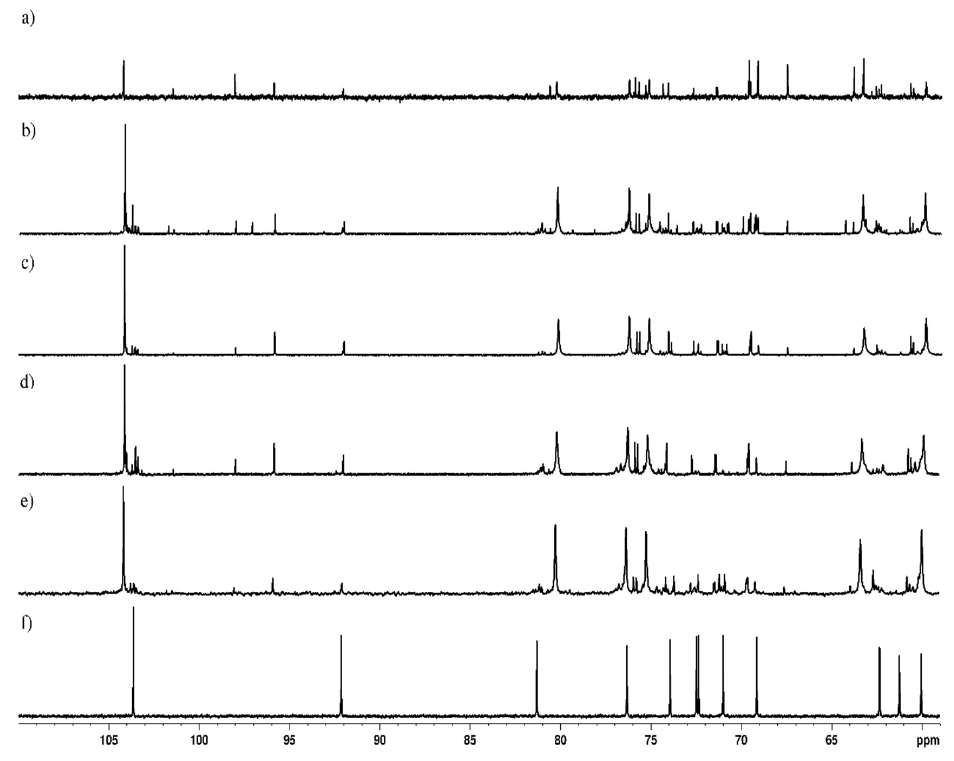
(Table 3) were identical with those levan produced by Zymomonas mobilis , Tanticharoenia sakaeratensis [46], Bacillus subtilis MTCC 441 [47]. G. cerinus DSM 9533 T was the only exception showing 12 carbon signals attributable to sucrose structure ( α -D-glucopyranosyl- (1 → 2)- β -D-fructofuranoside) [45,48,49]. This could be due to the low amount/quantity of fructan produced by G. cerinus DSM 9533 T , which could not be detected. Moreover, chemical shifts of C2 and C6 which correspond to the β -(2–6)–linkages were in accordance with the controls and previous literature confirming the presence of levan [3,50].